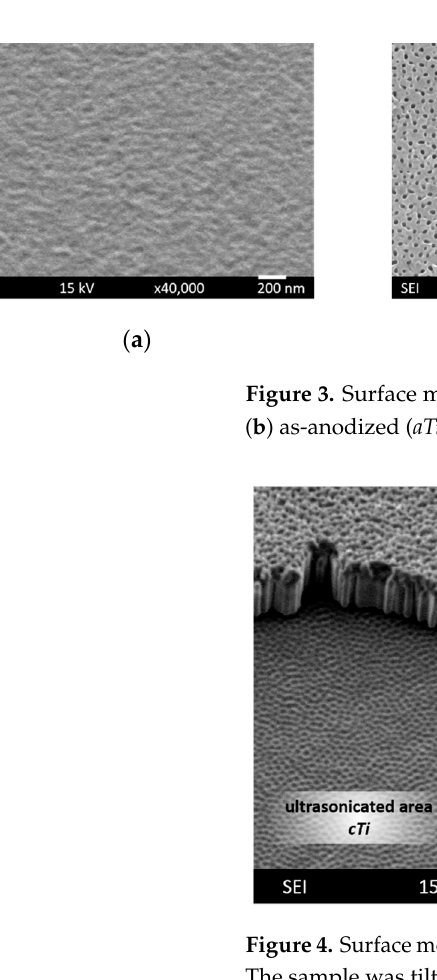
Figure 4. Surface morphology of nanoporous ( aTiO 2 ) and ultrasonicated ( cTi ) areas from SEM anal ‐ have a depth and diameter of 20 ± 5 and 100 ± 20 nm, respectively (Figure 5c). ysis. The sample was tilted at 30°.